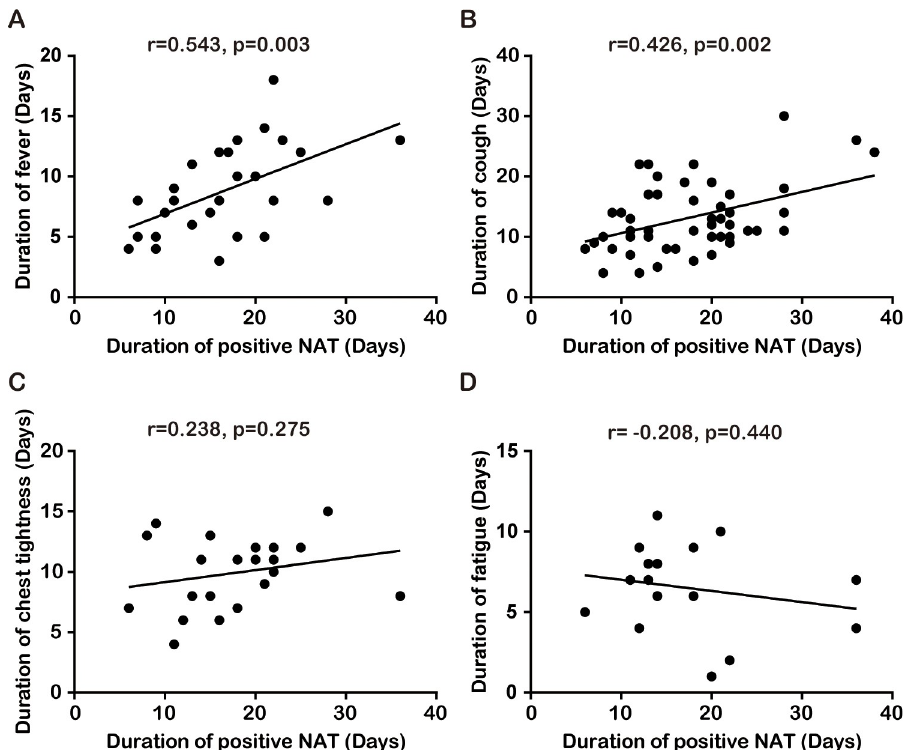
Fig 2. Linear correlation analysis between the duration of positive NAT results and the duration of cough (A), fever (B), chest tightness (C), and fatigue (D). NAT results, nucleic acid test results for SARS-CoV-2.